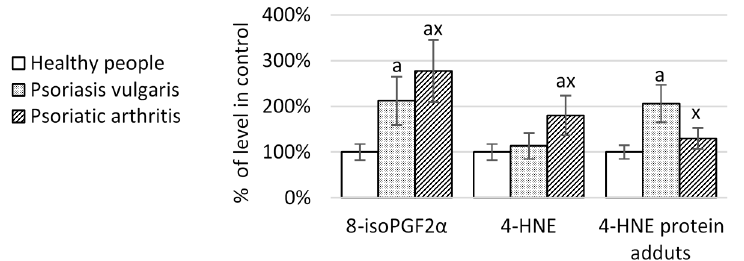
Figure 2. The level of phospholipid oxidative modifications products and of 4-HNE-protein adducts in mononuclear cells of healthy peoples (n = 16) and patients with psoriasis vulgaris (n = 32) and psoriatic arthritis (n = 16). 8-isoPGF2 α , F2 α -8-isoprostaglandin; 4-HNE, 4-hydroxynonenal. Data points represent the mean ± SD; a, significantly different from healthy subject, p < 0.05; x, significantly different from patients with psoriasis vulgaris, p < 0.05.